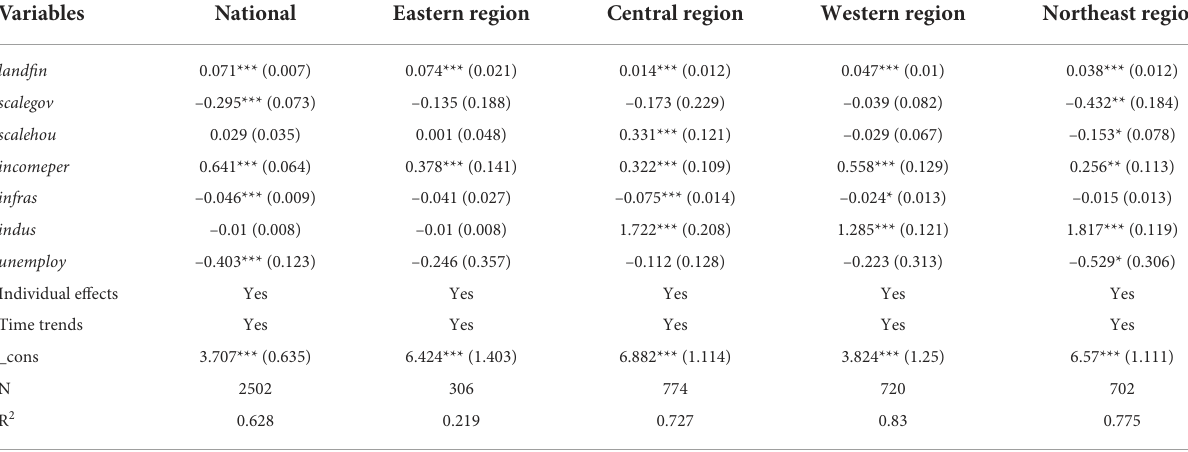
TABLE 4 The panel data regression results of land finance impacting on economic growth.